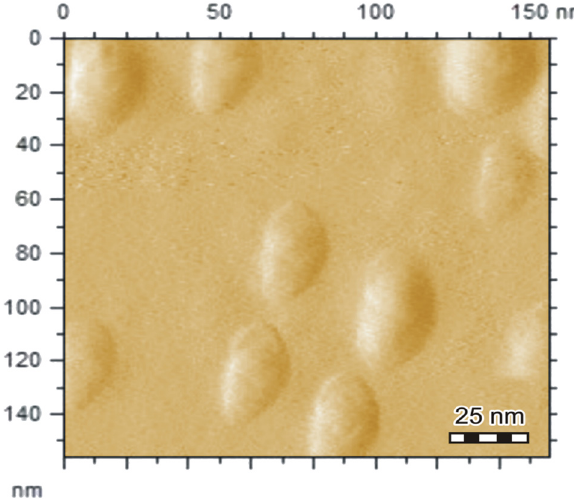
Figure 18: Kinetic study of catalytic degradation of Rhodamine